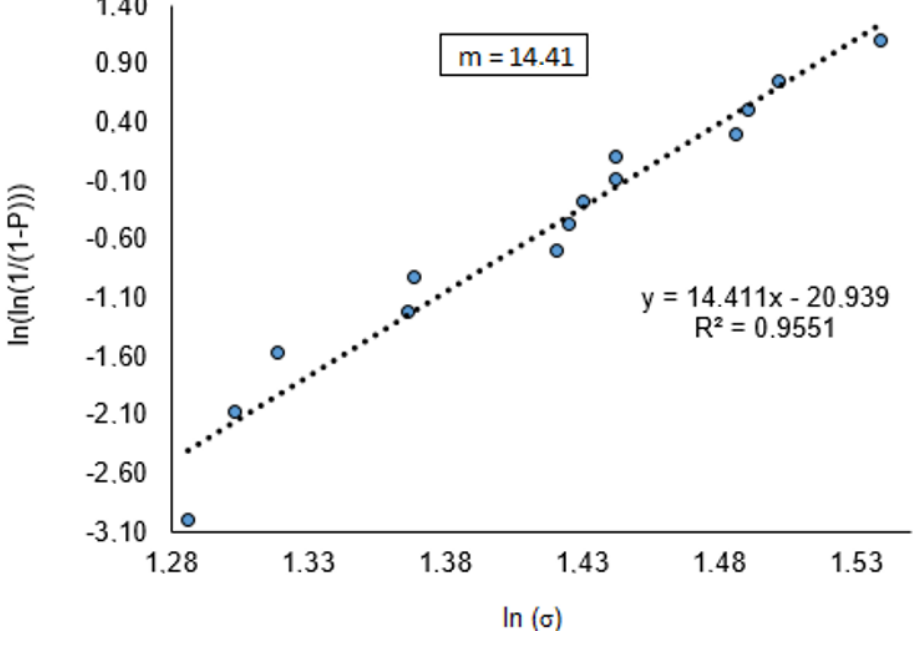
Figure 6. The Weibull chart (PBB).